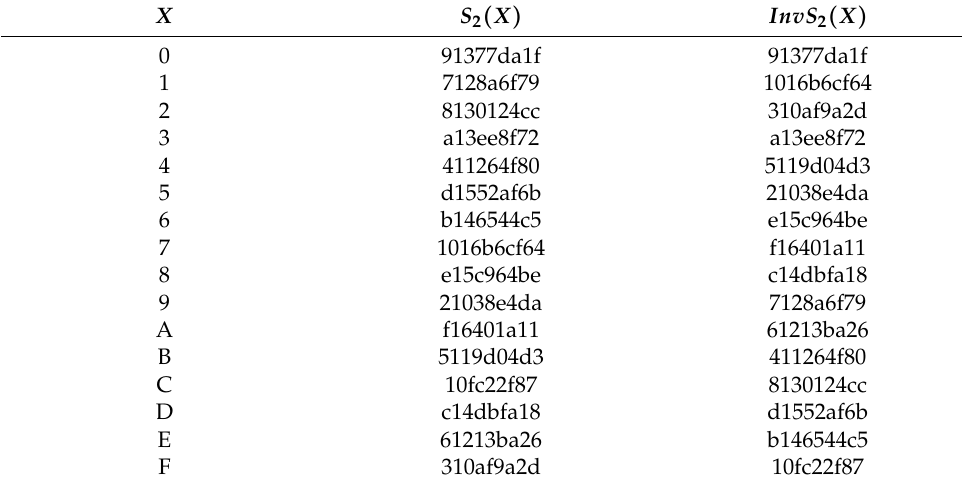
Table 12. New generated 32-bit output S-Box to replace Table